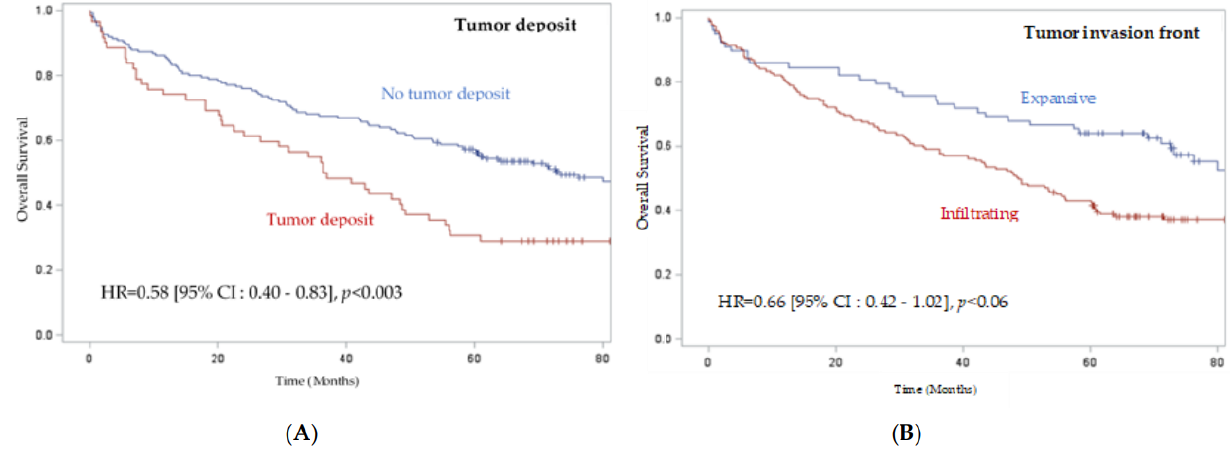
Figure 2. Prognostic factors studied and overall survival in 229 patients with colon cancer. ( A ) Tumor deposit impact on overall survival in patients with colon cancer. ( B ) Impact of tumor front invasion on overall survival in patients with colon cancer. Table 3. Results of the log rank test: mean survival time according to prognostic factors studied in 229 patients with colon cancers for overall (OS) and recurrence-free survival (SSR). OS Mean Survival Time (Months) p -Value